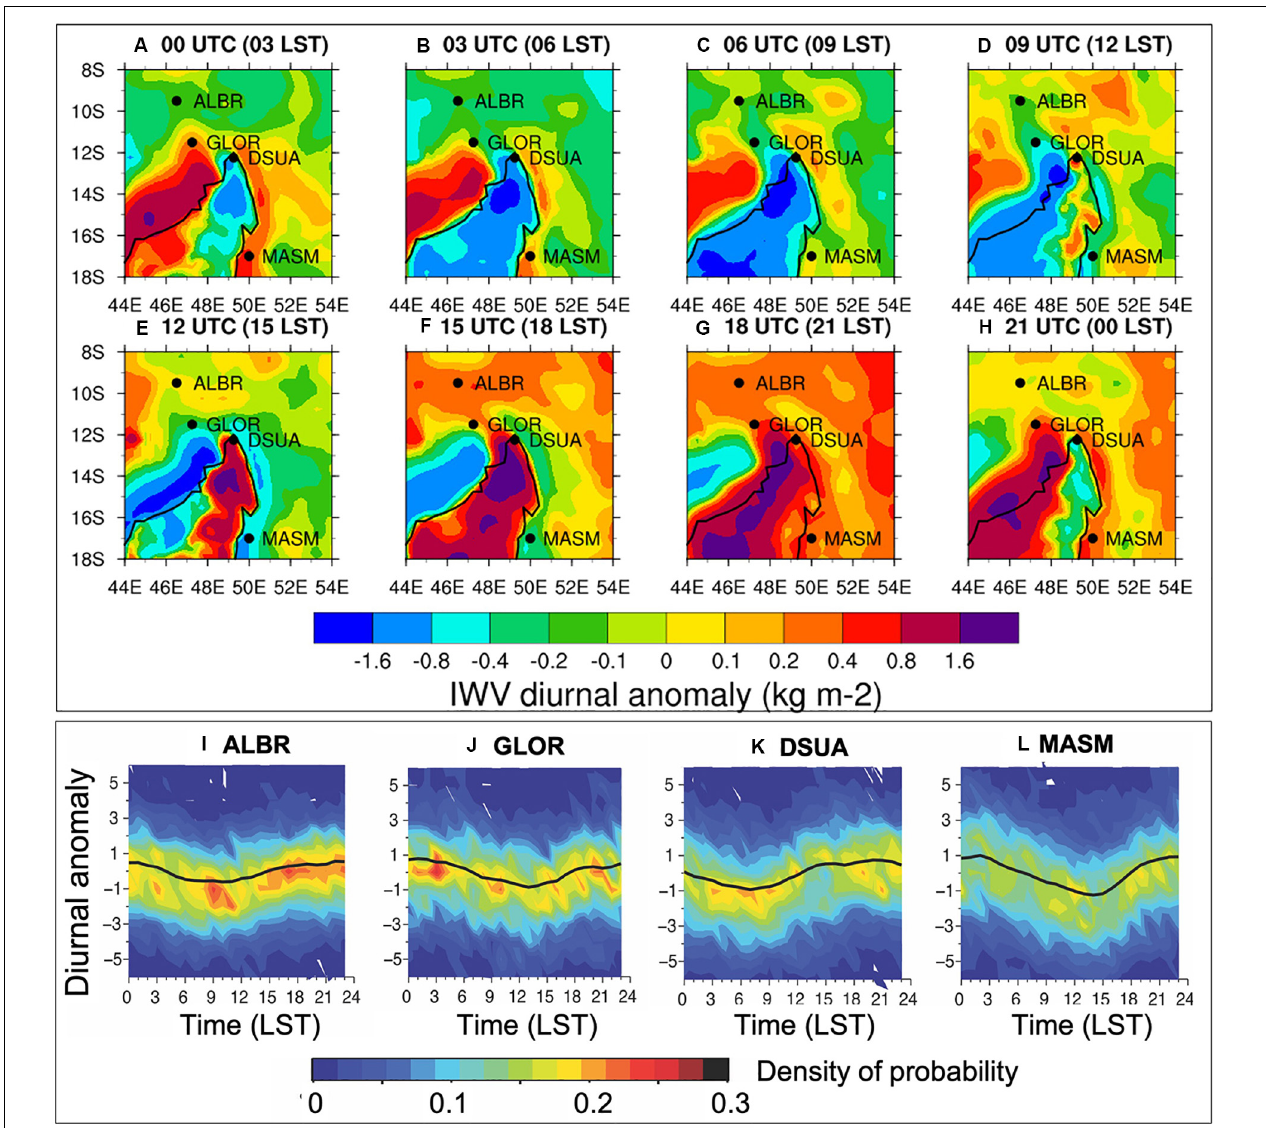
FIGURE 3 | Top and middle panels show IWV diurnal cycle anomaly (kg.m - 2 ) computed from ERA5 data between 44–54 ◦ E and 8–18 ◦ S, by steps of 3 h. Bottom panel shows the density of probability (shaded) and average diurnal anomaly (black line) of IWV (kg.m - 2 ) derived from GNSS data collected in 2019 at (I) ALBR, (J) GLOR, (K) DSUA and (L) MASM. Black dots in (A–H) show the locations of GNSS stations used in (I–L)